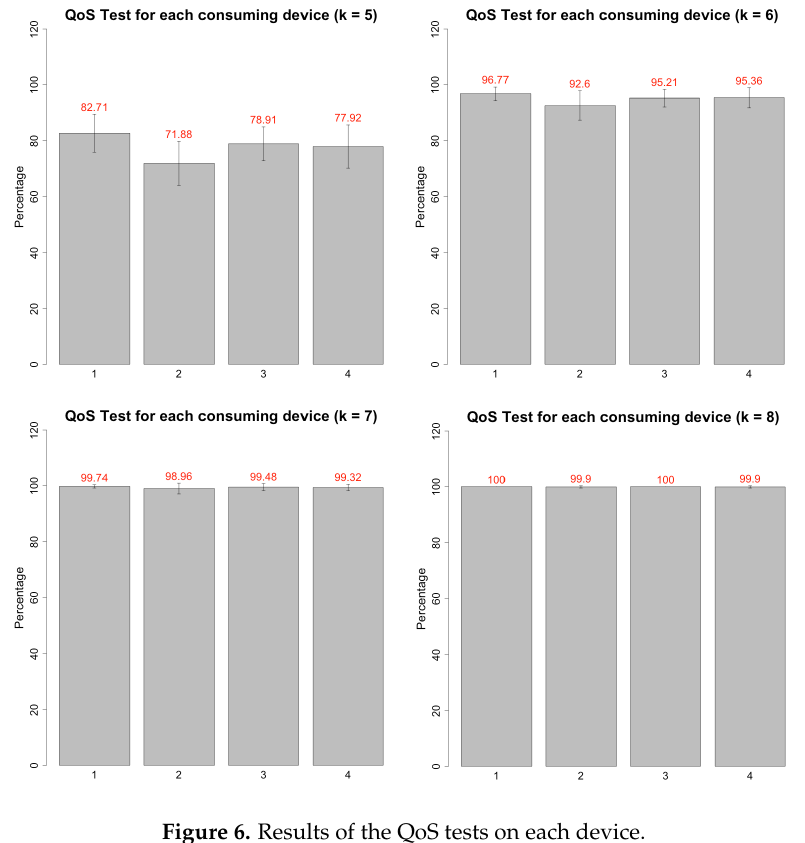
Figure 6. Results of the QoS tests on each device.